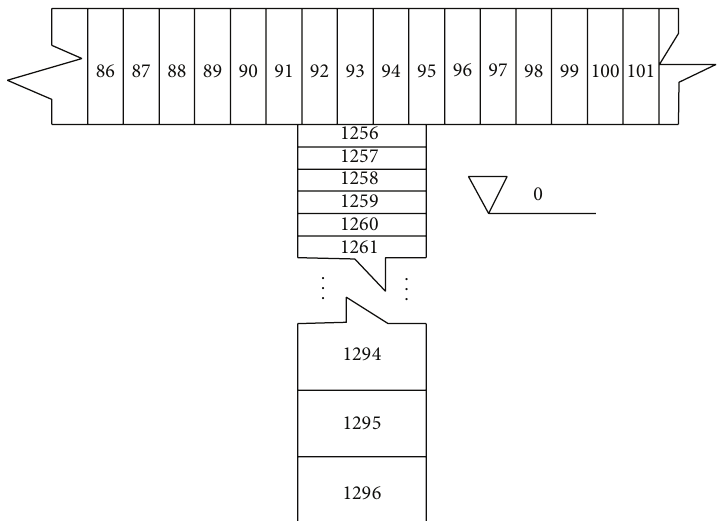
Figure 10: Division of units for pier 78.